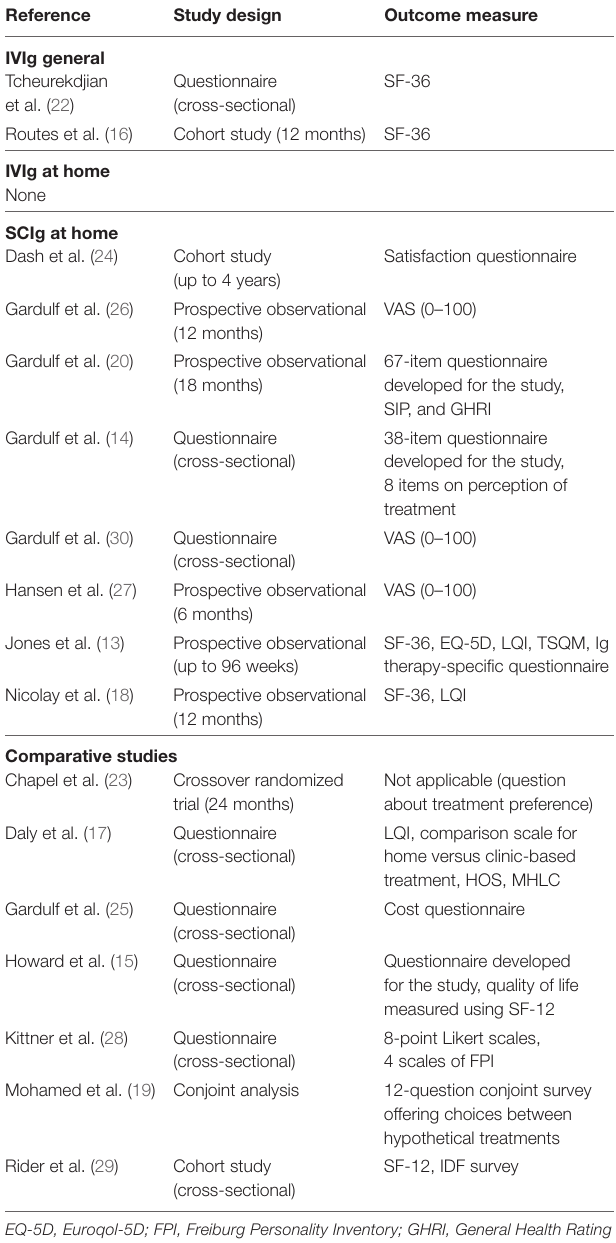
taBLe 2 | Study designs and outcome measures